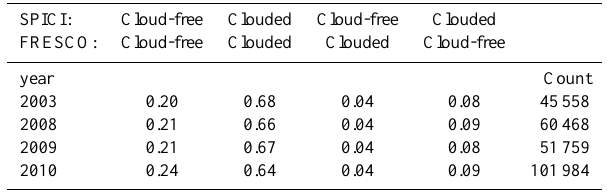
Table 3. Comparison of scene identifications between SPICI and MICROS over time. A grand total of 364 × 10 3 SPICI observa- tions (after filtering for solar zenith angle and latitude) were com- pared to co-located averaged MICROS observations. A scene is considered clouded by MICROS when the average MICROS cloud- fraction over the scenes is more than 10%. The table shows the fraction of the total number of SPICI observations which fall under the catagory indicated in the top of the table.Total number count of SPICI obervations employed for the comparison for each year in the right column.